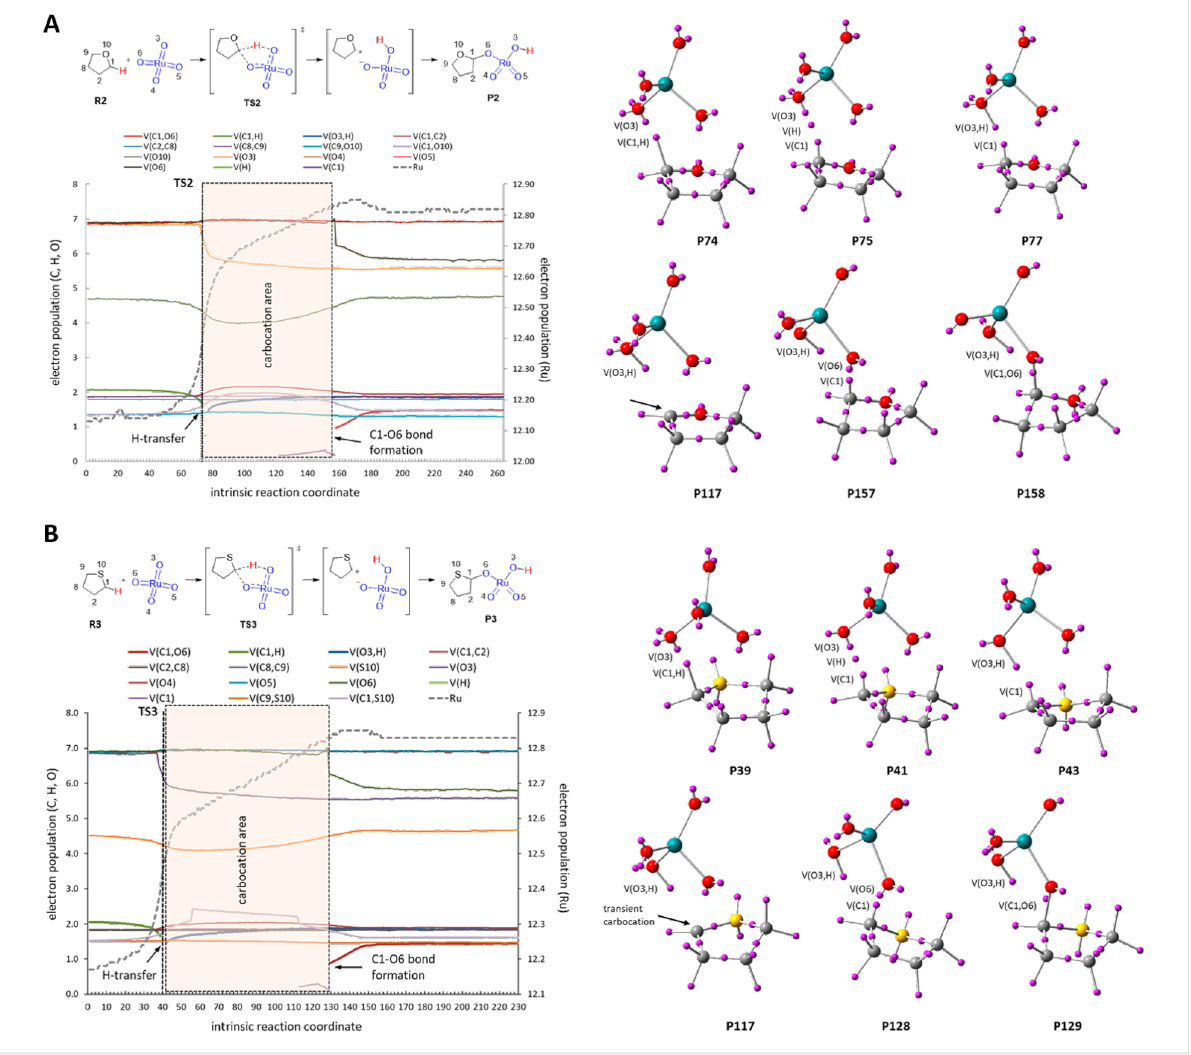
Figure 3: ELF analysis for the oxidation of tetrahydrofuran ( R2 , A) and tetrahydrothiophene ( R3 , B). Left: evolution of the electron population along the IRC. Right: Descriptors of basins at selected points of the IRC.